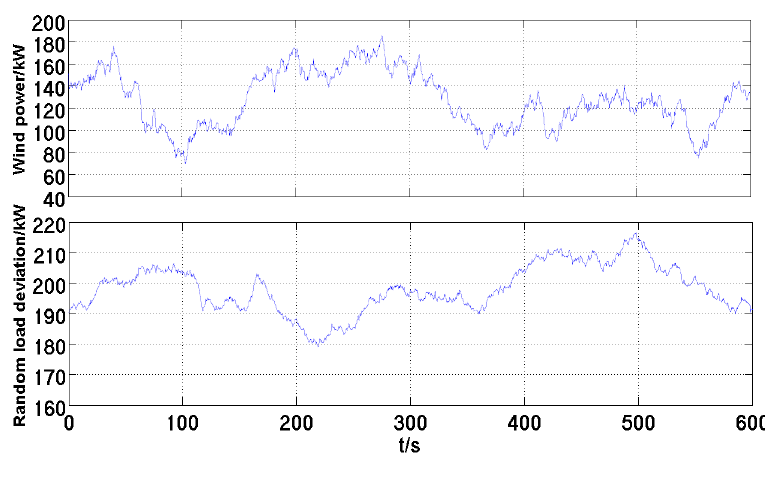
Figure 2. Wind power output and random load